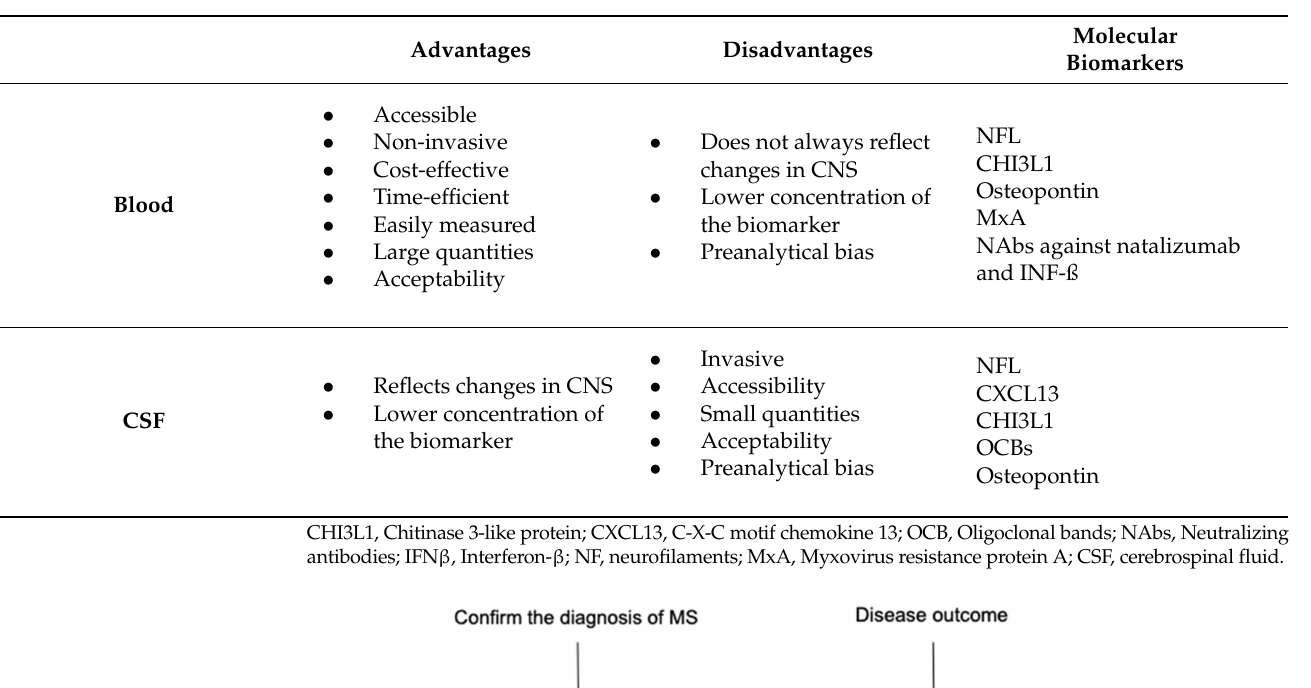
Table 1. Advantages and disadvantages of blood and CSF biomarkers. Molecular biomarkers discussed in the review.